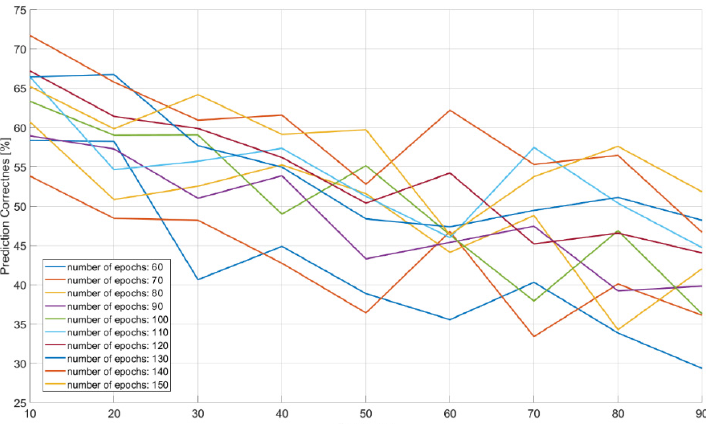
Figure 15. Effectiveness of recognizing radar signals on the basis of the time waveform shape modulation during the changes of the size of the training dataset and the number of iterations in the training algorithm.